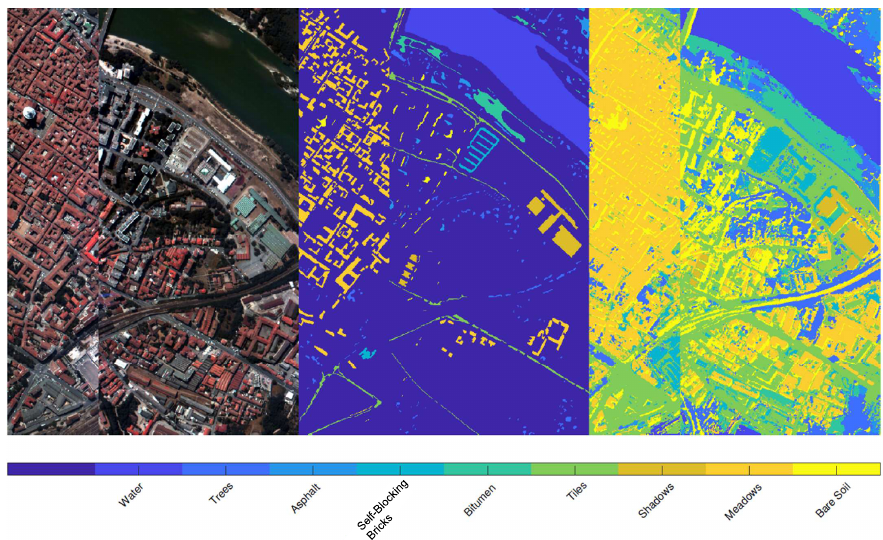
Figure 7. Result of the segmentation of Pavia Center using the ground truth labels as atlas. From left to right: image of the landscape in false colors, labels of the ground truth, final result. The latter panel shows that all the roofs are remarkably recognized, as the shadows they project on the ground. The vegetation is segmented with a very high level of precision. We reported the labels as reported in the database we used for these experiments: there are clearly some errors, since some classes (such as Shadows, Meadows and Bare Soils) refers to objects that are not the ones described by these